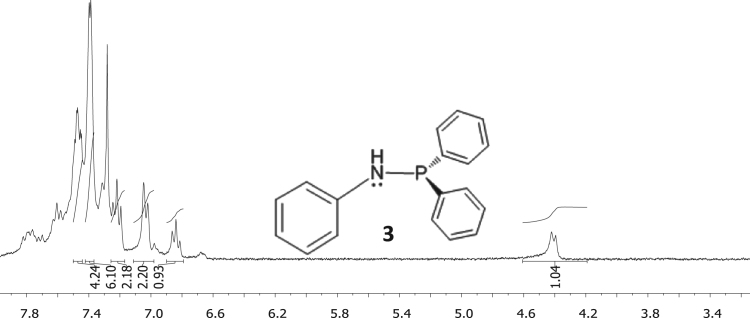
1H NMR of diphenylphosphino amide C6H5NHPPh2, 3.